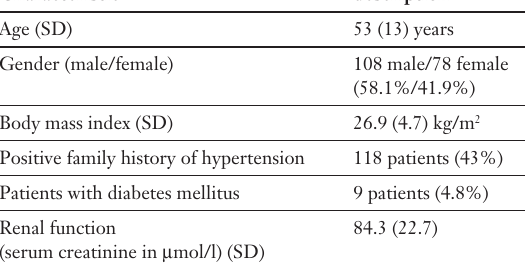
Diagnostic performance of standard dipstick testing for detection of microalbuminuria (as a marker of a hypertensive renal target organ damage) compared to albumin/ creatinine ratio (assumed as gold standard for